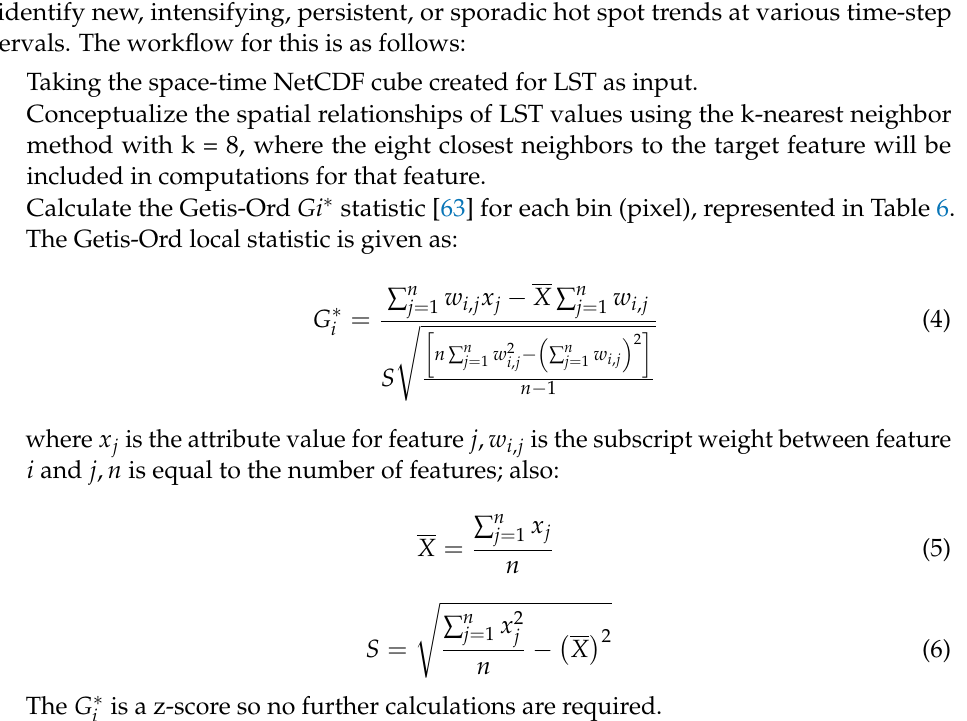
Table 6. G ∗ statistic values for cold spot and hotspot classes at different significance levels. i